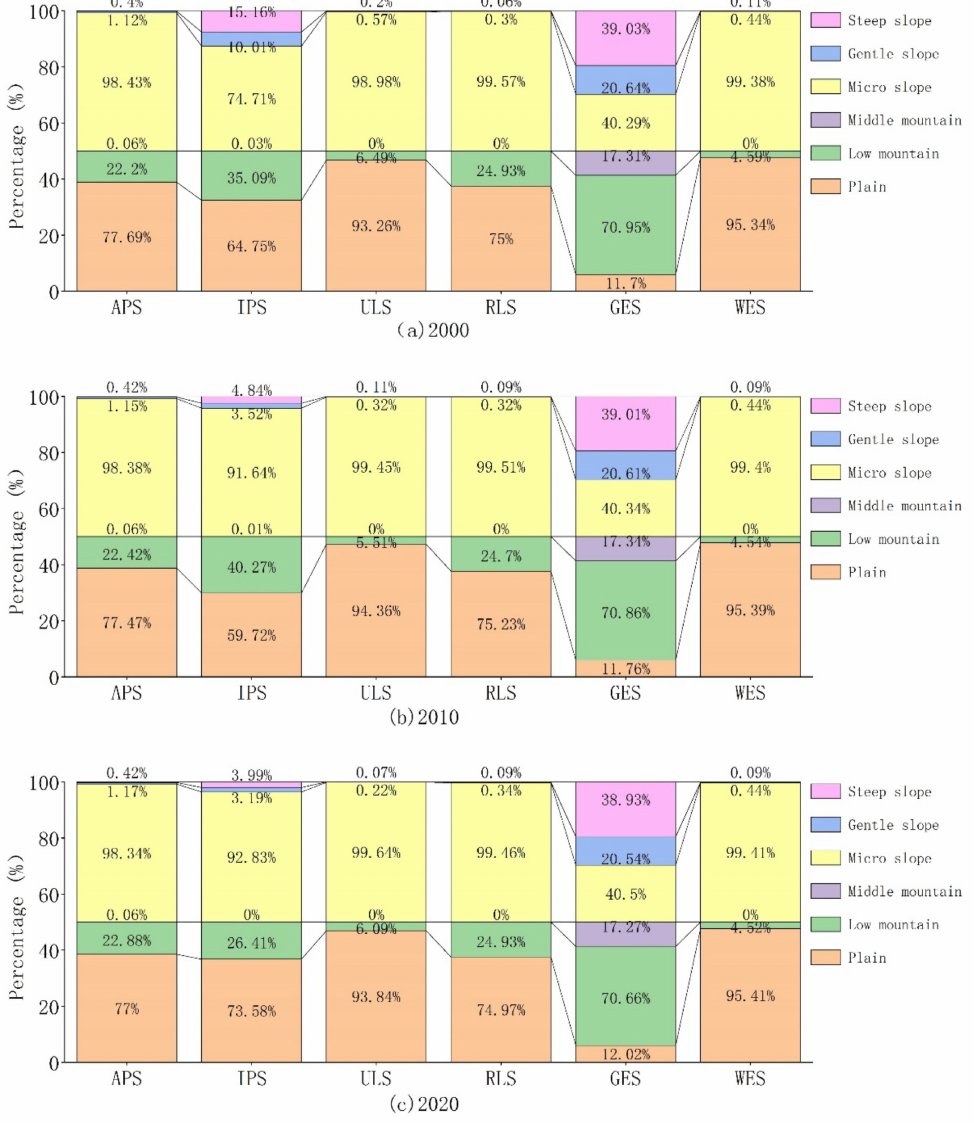
Figure 9. The area proportion of the PLES in the Chaohu Lake Basin under the conditions of slope and elevation: ( a ) 2000; ( b ) 2010; ( c )